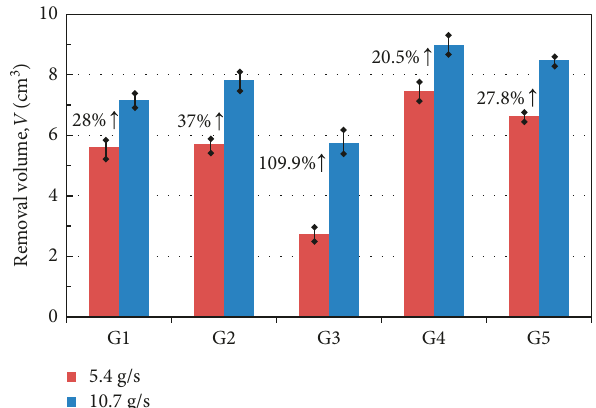
Figure 5: Comparison of removal volume: the removal volume at 5.4 g/s of the abrasive feed rate and removal volume at 10.7 g/s of abrasive feed